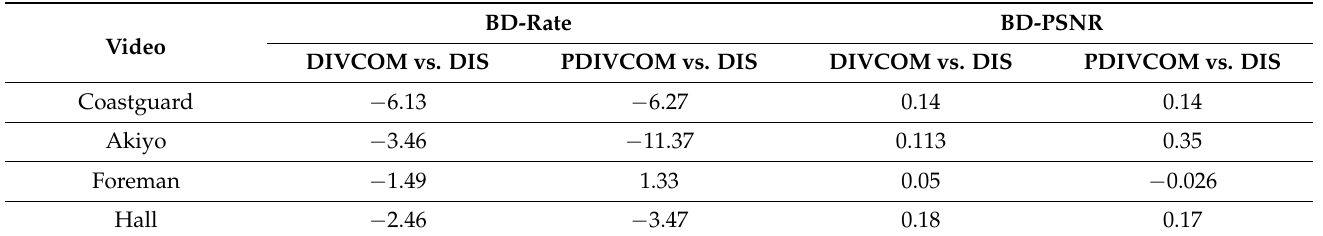
Table 10. Comparison of BD-Rate and BD-PSNR between DIVCOM and PDIVCOM with